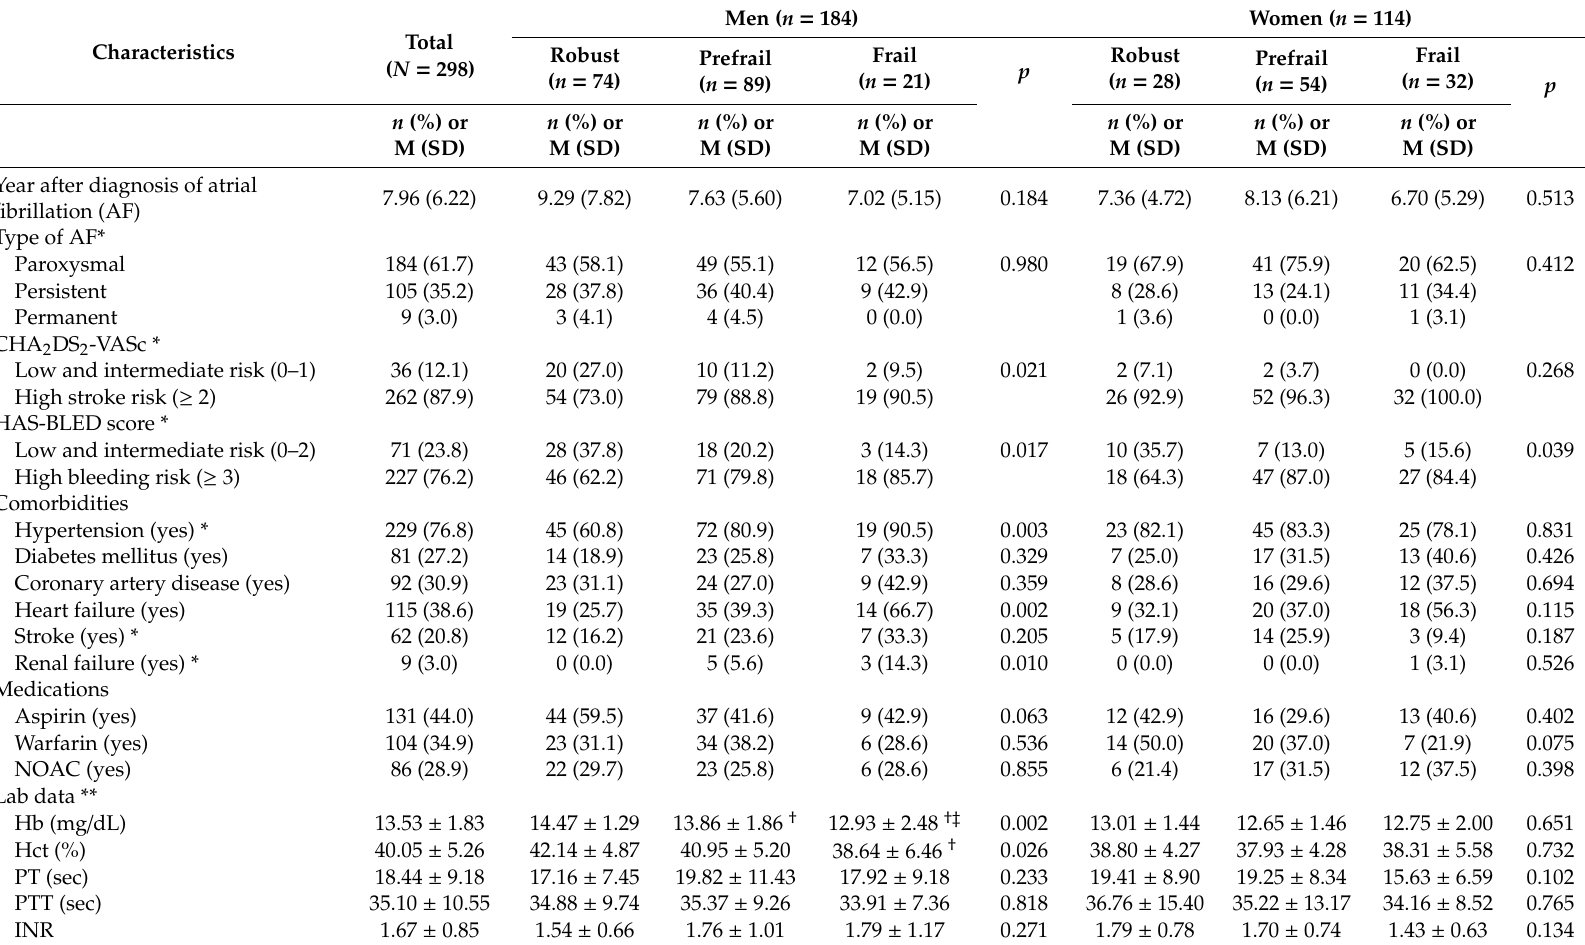
Table 2. Clinical characteristics by gender and frailty status ( n =